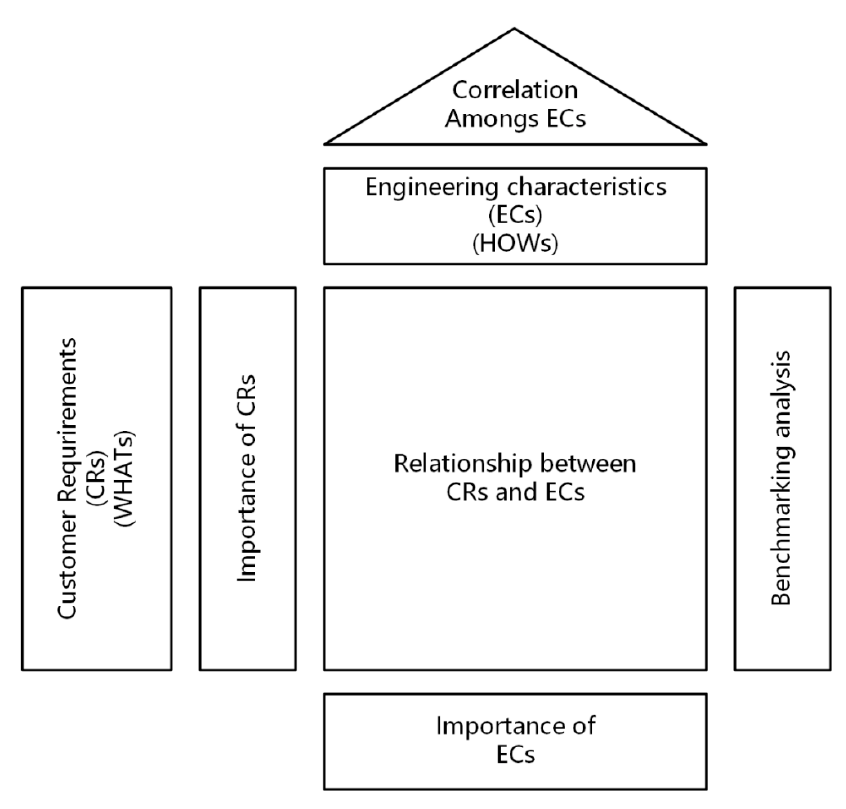
Figure 1. The house of quality (HOQ).